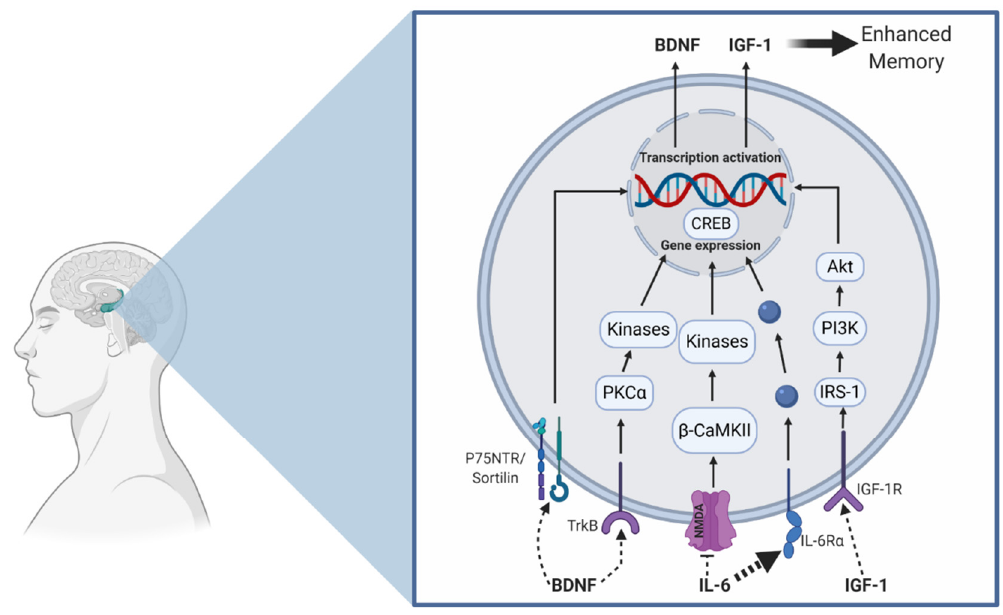
Figure 2. Hypothesized aerobic and resistance exercise model on improved hippocampal memory function. Aerobic exercise may increase proBDNF and hippocampal BDNF production, which